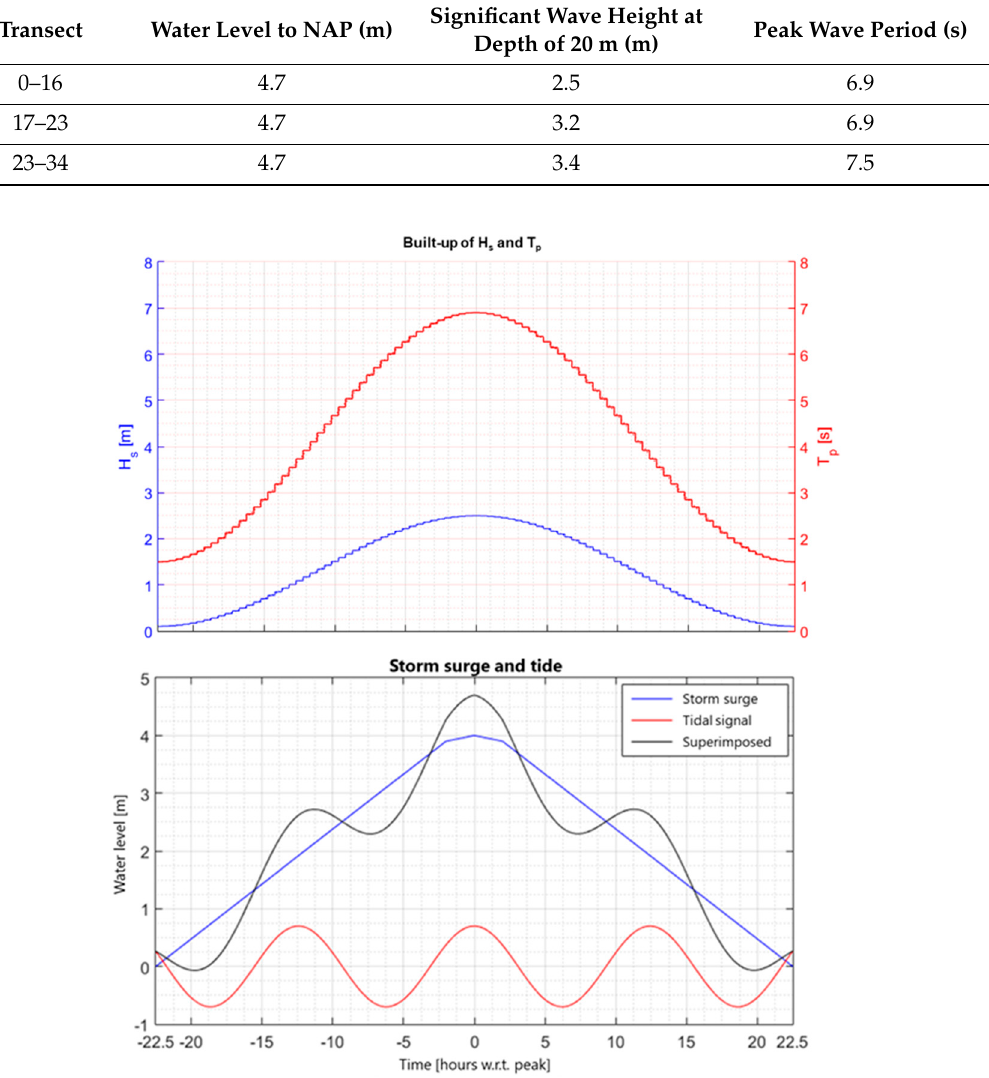
Figure 5. Time development of significant wave height and peak period for transect 0–16, during the 1/4000 storm event (upper) and water level variation (lower).